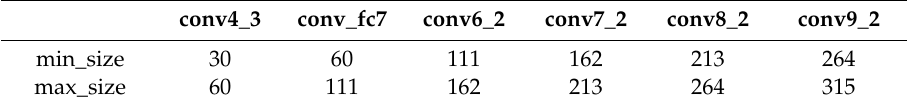
Table 6. Box size design table for each network layer.